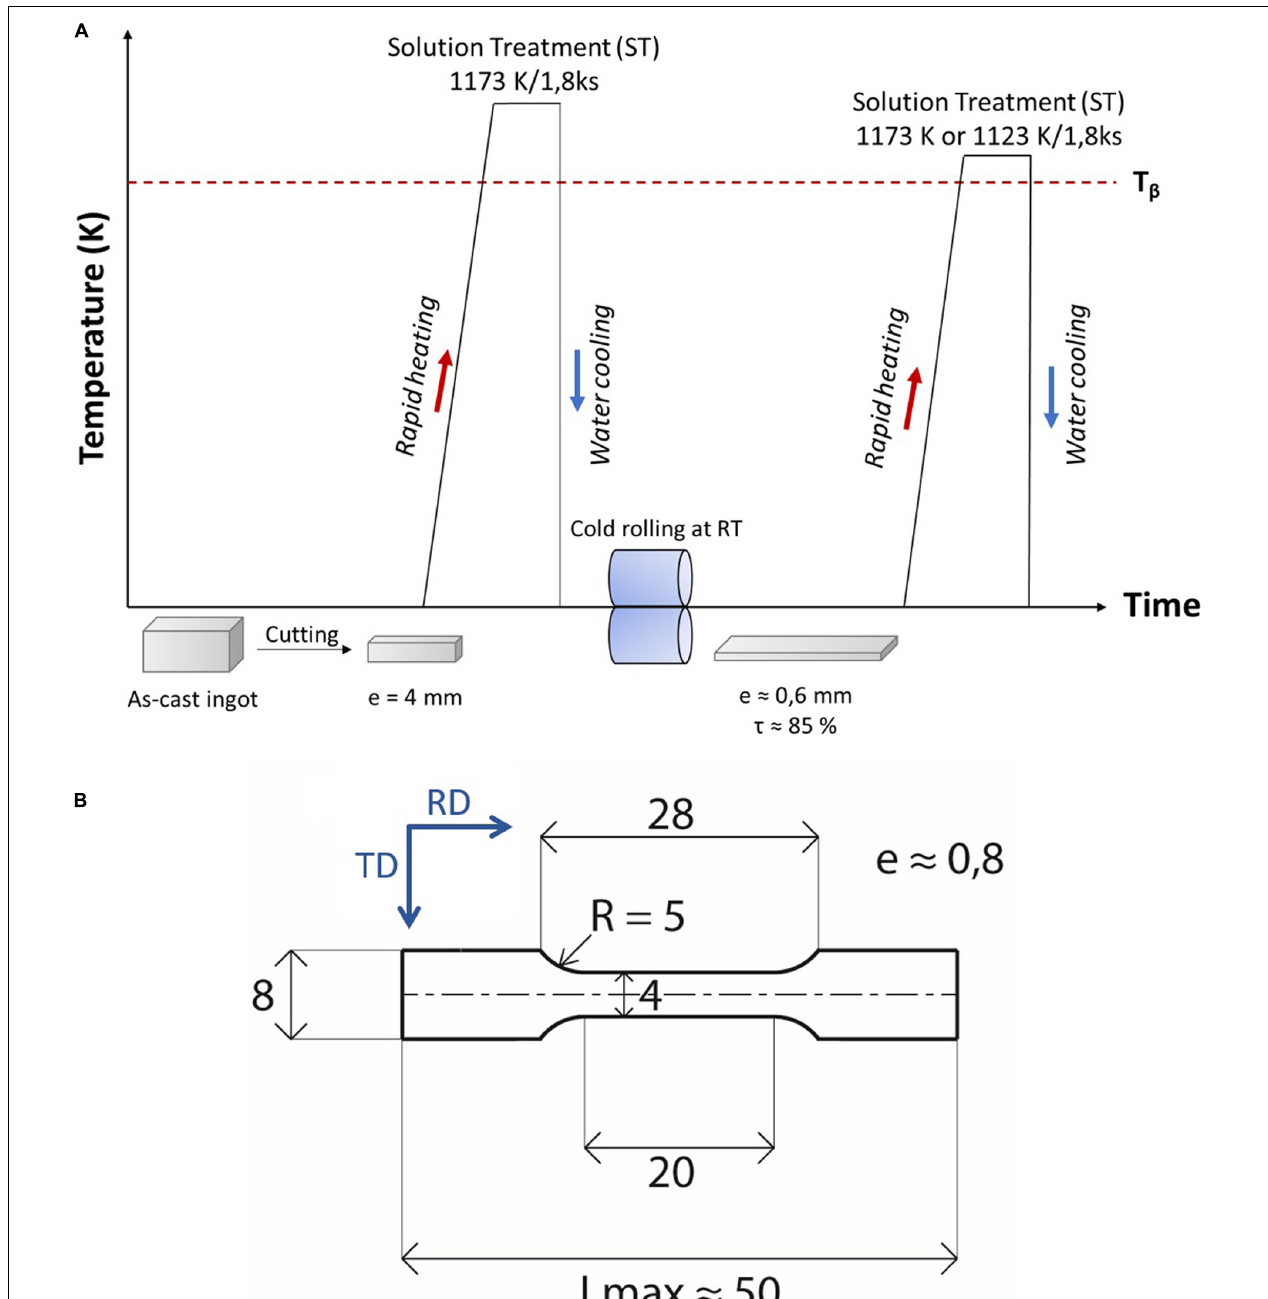
FIGURE 1 | (A) Scheme of the Ti–12Mo and Ti–8.5Cr–1.5Sn thermomechanical sequences. (B) Scheme of tensile specimen